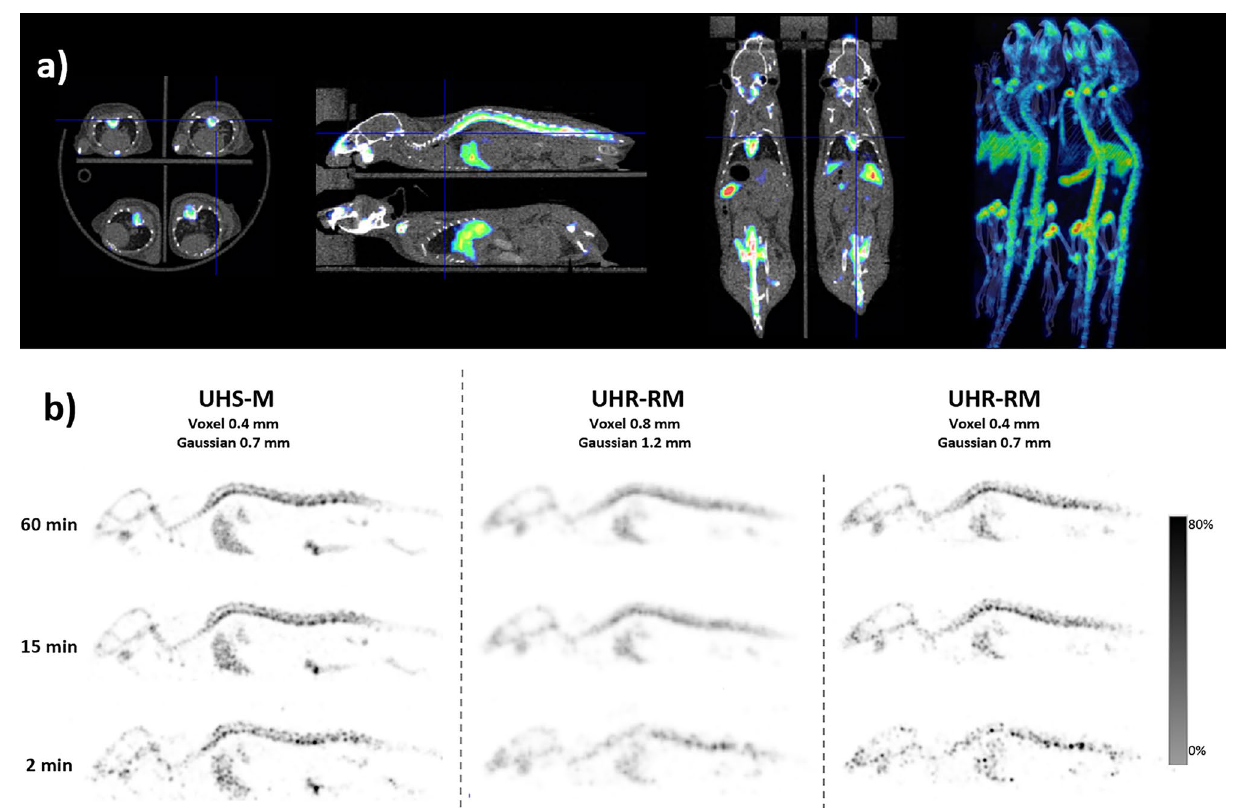
Figure 6. Mouse bone scan. ( a ) Axial, sagittal and coronal slices and MIP reconstruction of SPECT/CT fusion images to show multi-mouse acquisitions from four mice simultaneously. ( b ) SPECT sagittal slices of a mouse injected with 99m Tc-HDP using either the UHS-M or the UHR-RM collimators applying different reconstruction protocols. The 99m Tc HDP uptake is clearly detected in the bones (vertebrae, skull) and also in the